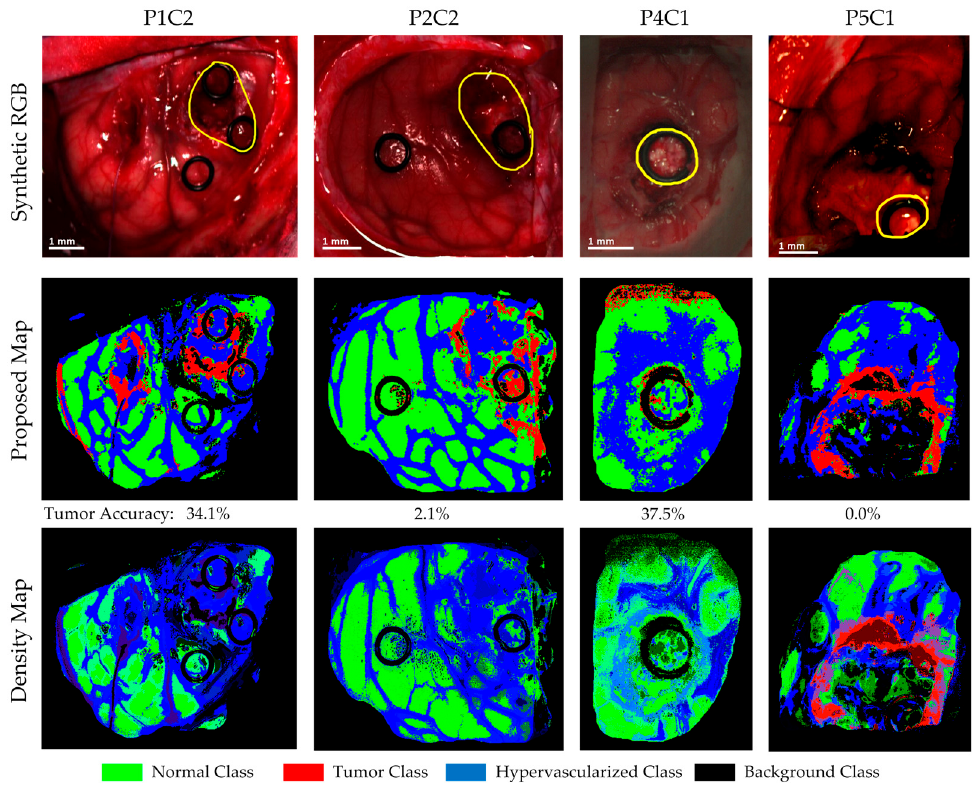
Figure 11. Classification maps of the four test HS images acquired after initial tumor resection and their respective tumor accuracy below each map. In these results, it is possible to observe the limitations of the current system when images are captured during the tumor resection procedure.